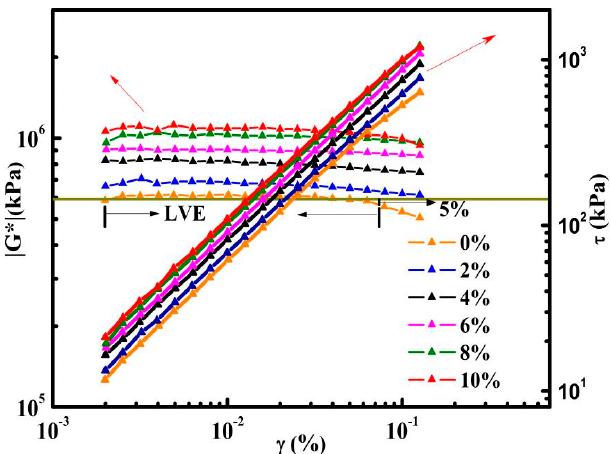
Figure 4. Strain sweep results of control asphalt and graphene modified asphalts (GMAs) at − 30 ◦ C.